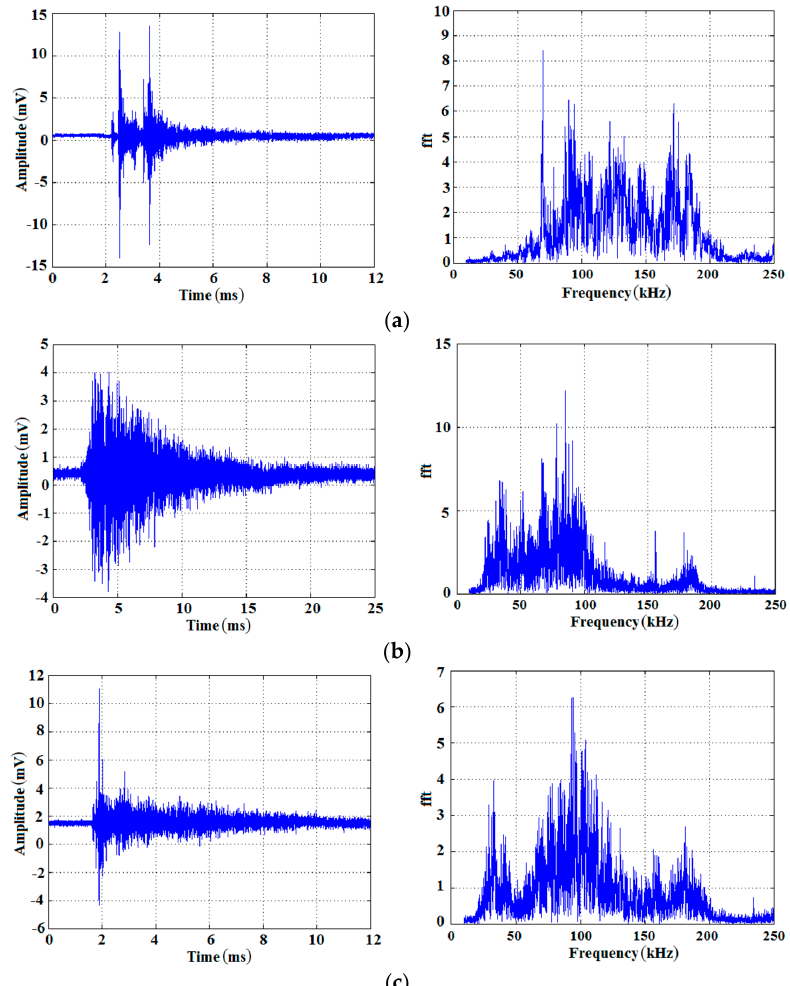
Figure 7. AE signals caused by impacts of structural elements: ( a ) Zone I; ( b ) Zone II; ( c ) Zone